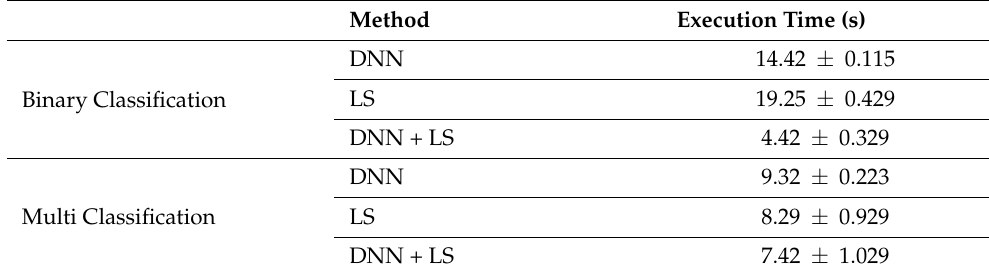
Table 10. Comparison of the prediction time in seconds.